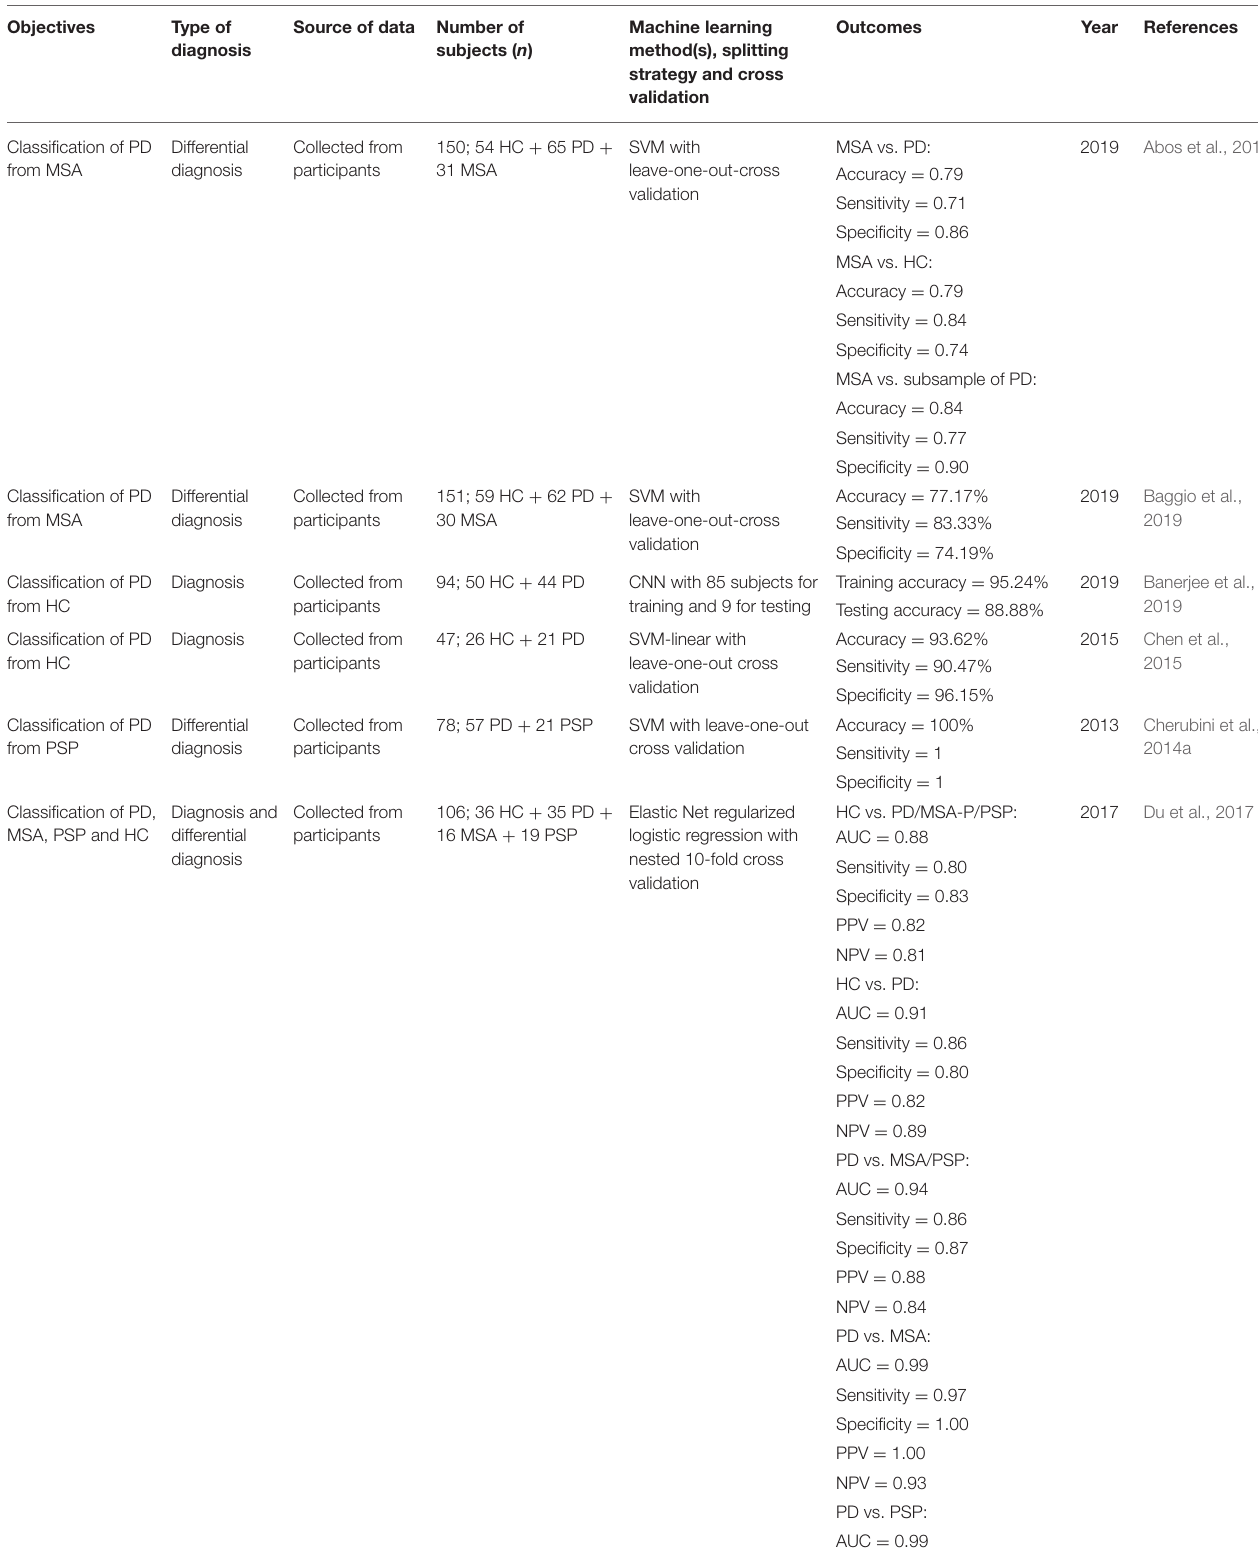
TABLE 6 | Studies that applied machine learning models to MRI data to diagnose PD ( n